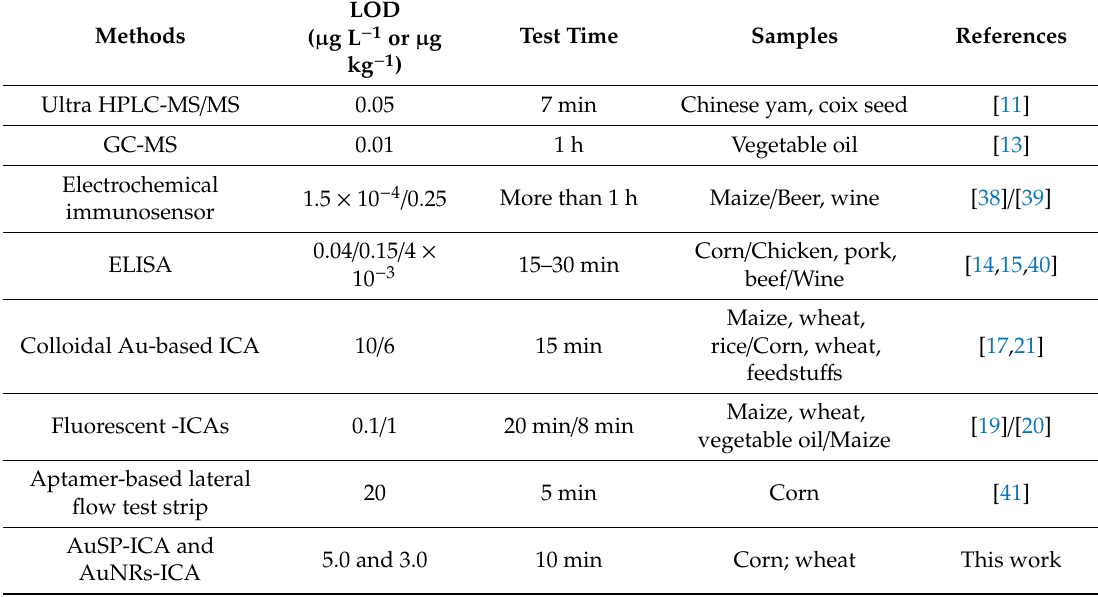
Table 1. Results of the comparison of di ff erent reported methods for ZEN